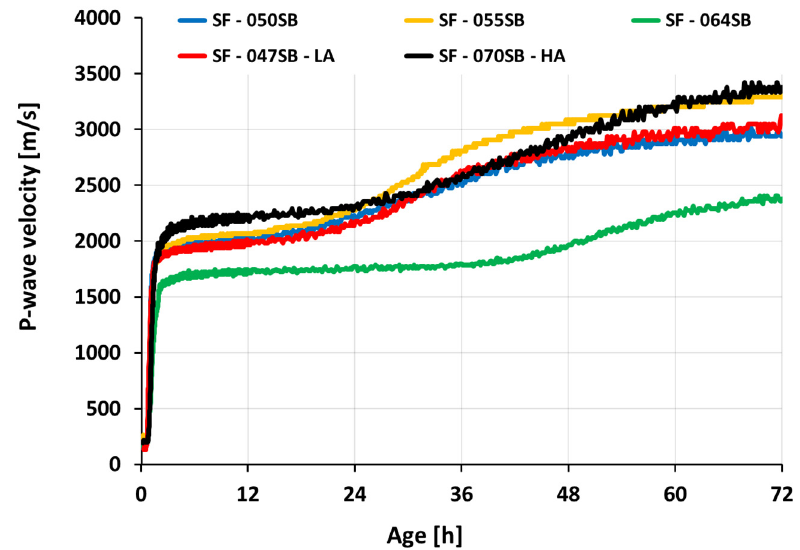
Figure 6. UPV evolution as a function of age.